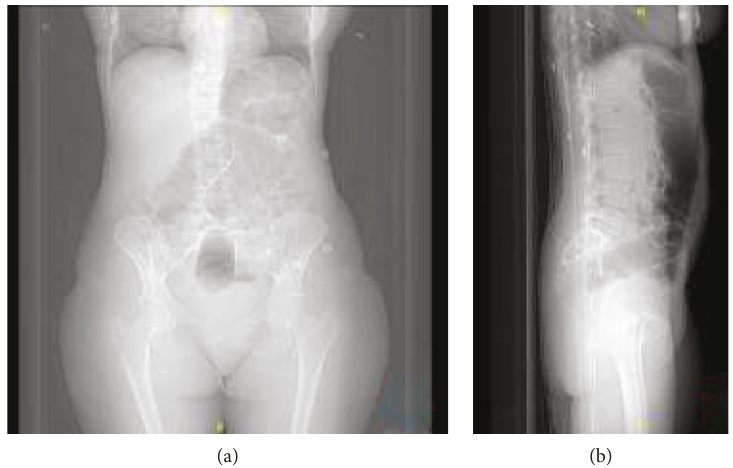
Figure 1: Standard frontal (a) and lateral (b) radiographs reveal the foreign body.